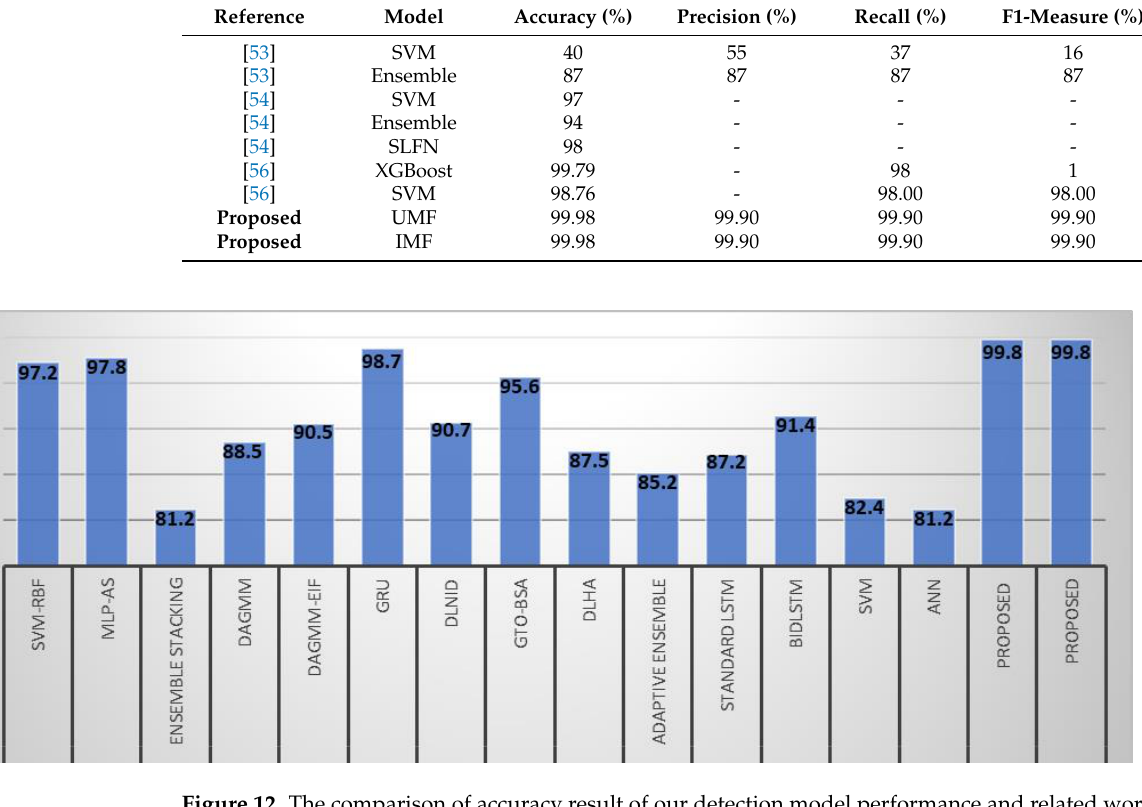
99.8 Figure 13. The comparison results of our multi classification model performance and related works of IoTID20 dataset.